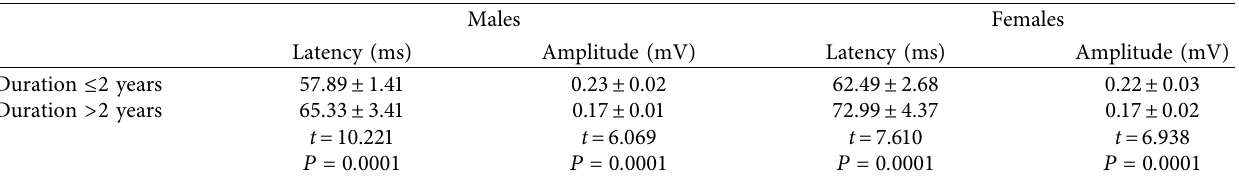
Table 3: Comparison of mean BCR latency and amplitude between the long course of disease ( > 2 years) and shorter course of disease ( ≤ 2 years) groups in the MSA